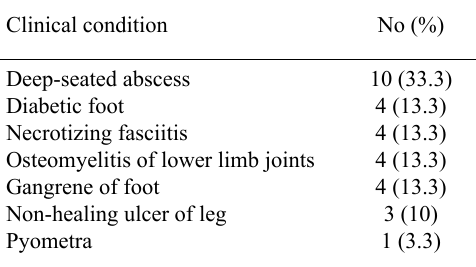
Table 1. The clinical infection profile of patients with P. anaerobius isolates